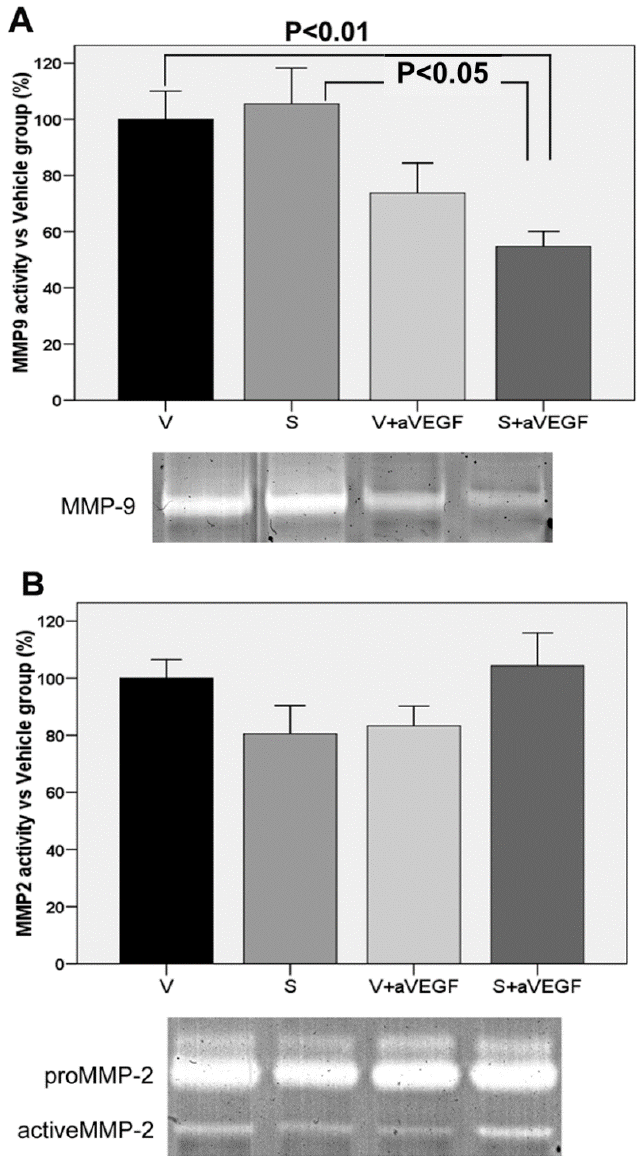
Figure 6. Enzymatic activity of matrix metalloproteinase (MMP)-9 ( A ) and MMP-2 ( B ). A: Upper: Representative MMP9 expression graphs (mean ± standard error of the mean (SEM)) for all experimental groups ( n = 10 eyes, β-actin was blotted as an internal control). Treatment groups included the nutritional supplement (S), the supplement and anti-vascular endothelial growth factor agent (S + aVEGF), and the vehicle and anti-VEGF agent (V + aVEGF) groups. Differences between groups S + aVEGF and V and between groups S and S + aVEGF were statistically significant (both p < 0.01). Lower: Representative MMP-9 activity zymograms for all study groups. B: Upper: Representative MMP-2 expression graph (mean ± SEM) for all experimental groups ( n = 10 eyes). No significant differences between groups were observed. Lower: Representative MMP-2 activity zymograms for all study groups.